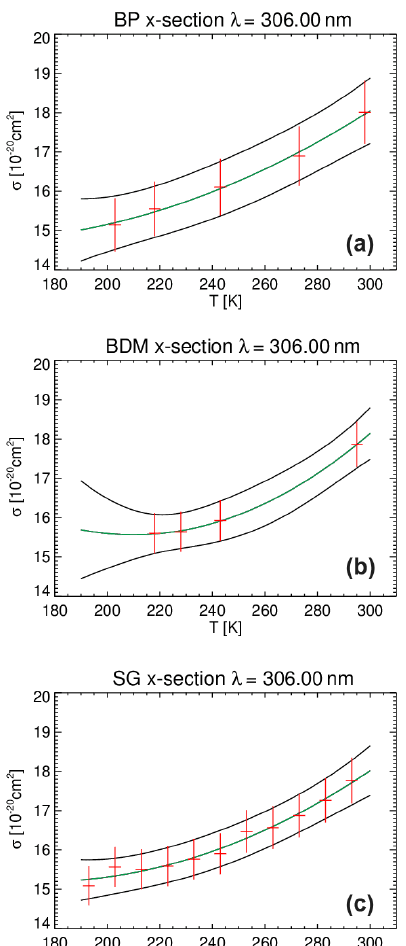
Figure 6. Modeled uncertainties of the three major ozone absorp- tion cross sections (BP, SG, and BDM) at 319.4nm based upon MC simulations. Red crosses show the measured data, including temper- ature and measurement uncertainties (here expressed as the square sum of random and systematic errors). The green curve is the fit- ted polynomial and the black curves show the modeled ± 2 σ uncer- tainty.